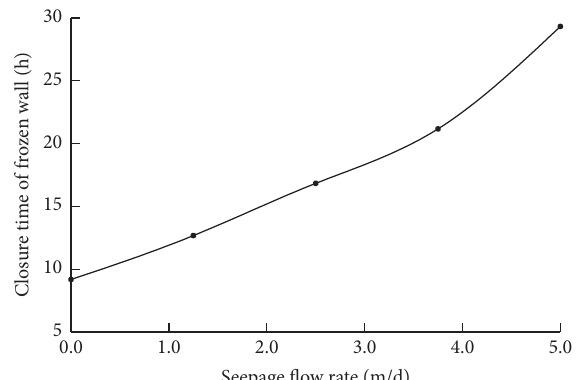
Figure 8: Closure time of frozen wall vs. groundwater seepage flow